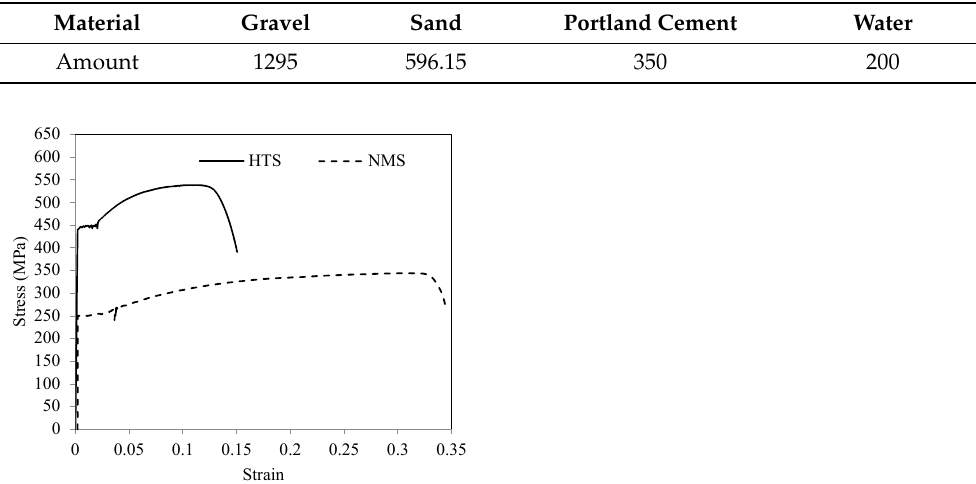
Table 1. Components of the used mix (kg/m 3 ).